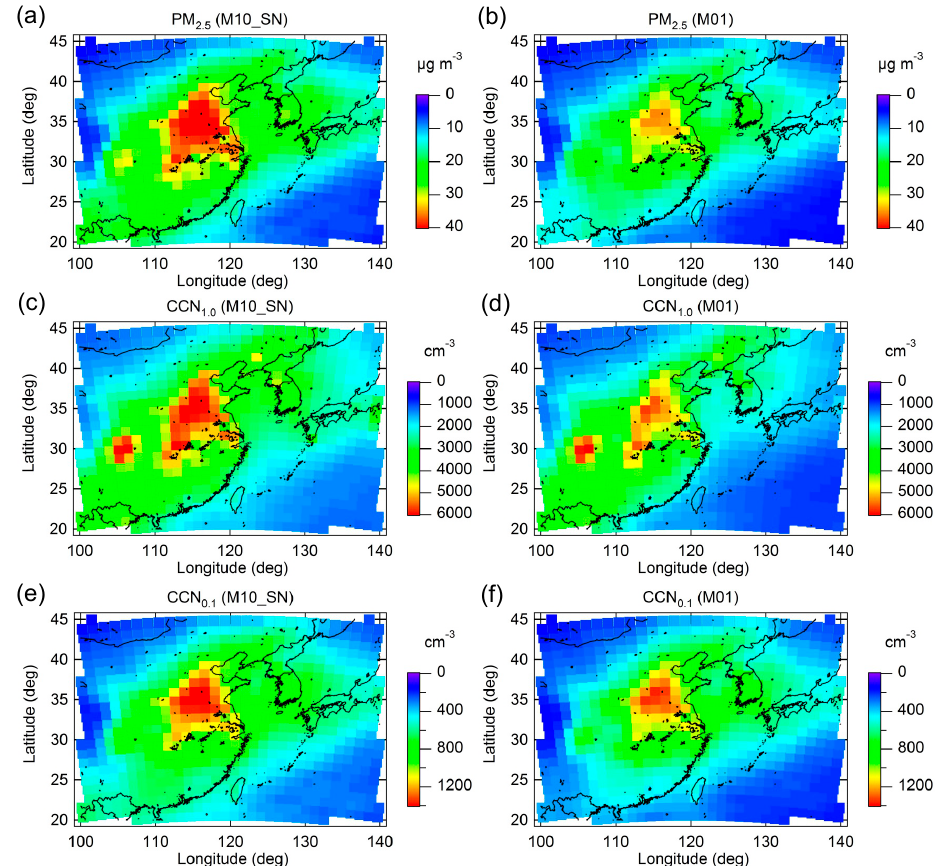
Figure 3. Comparison of the model simulation results with the observed average mass concentrations of BC ( M BC ) , sulfate ( M SO organic aerosols ( M OA ) , the volume concentration of light-scattering particles ( V LSP ) , the shell-to-core diameter ratio at a BC core diameter of 200nm (SC ratio), and the number concentration of Aitken-mode particles (10–130nm) (CN). The simulated aerosol concentrations are chosen from the horizontal and vertical grids closest to each site (for surface measurements at Fukue and Hedo) or flight track (for aircraft measurements during A-FORCE). Figure 4